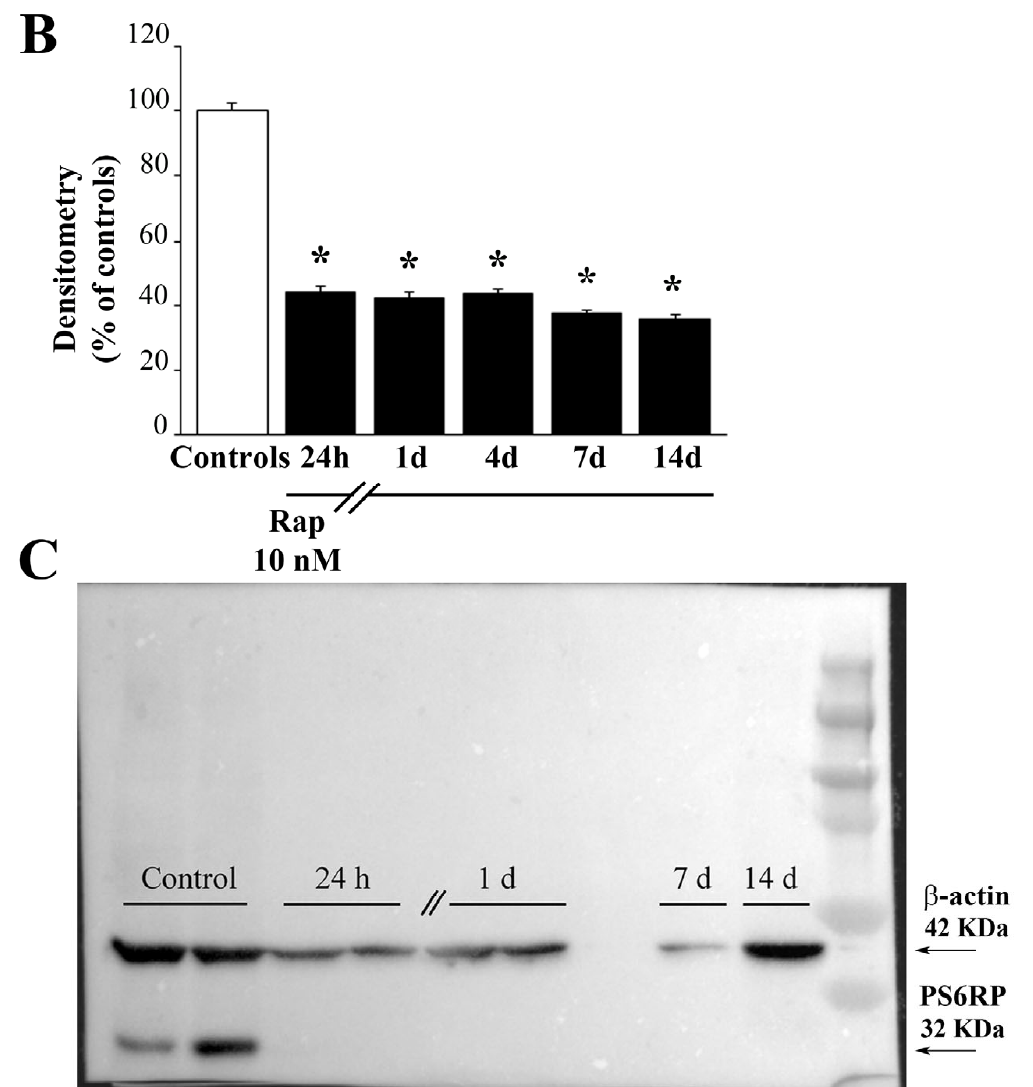
Figure 1. Rapamycin produces a long-lasting inhibition of mTOR activity. ( A ) Representative pictures showing the immunofluorescence of the protein PS6RP, which is a downstream enzymatic product of mTOR. Rapamycin produces a marked and long-lasting decrease of the PS6RP immunofluorescence. Densitometry of the PS6RP immunofluorescence ( B ) and the representative PS6RP immunoblotting ( C ) indicate that rapamycin induces a massive mTOR inhibition, which lasts at least 14 days following rapamycin withdrawal. Data in ( B ) are given as the mean percentage ± SEM of optical density measured in 100 cells per group (assuming controls as 100%). * p < 0.05 compared with controls. Scale bar = 12 μ m.